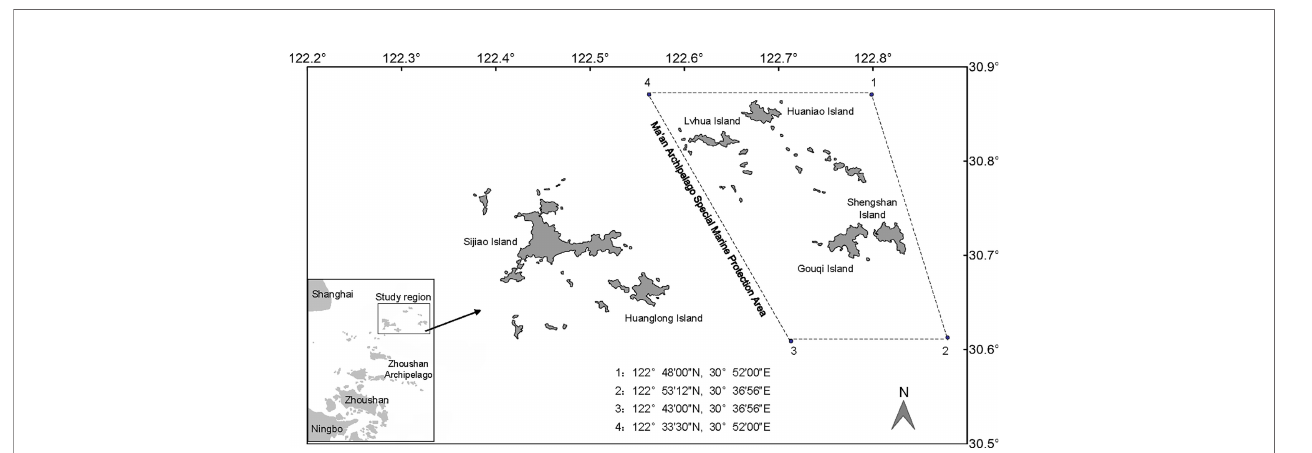
FIGURE 1 | Location of Shengsi and the Ma ’ an Islands National Marine Special Reserve. Shengsi County is located at the forefront of the Zhoushan fi shing ground in Zhejiang Province, including more than 400 large and small islands. Some islands of Shengsi Country and its surrounding waters belong to Ma ’ an Islands Marine Special Protection